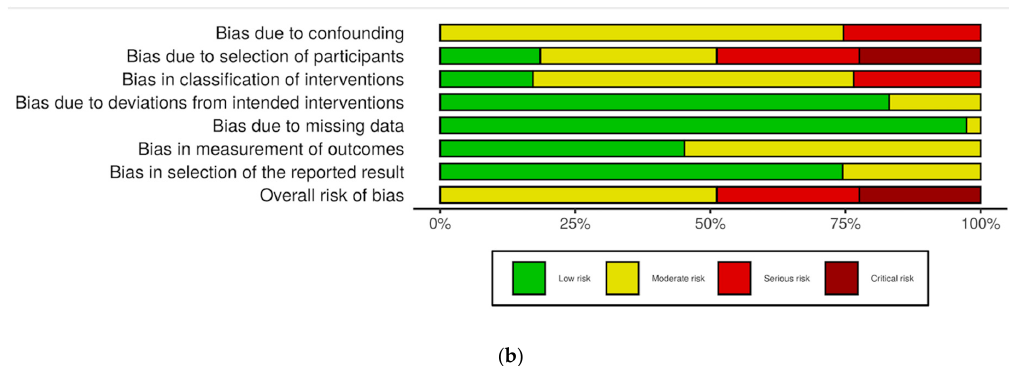
Figure A1. Risk of bias in non-randomized studies-of interventions (ROBINS-I) assessments of non-RCTs. ( a ) “Traffic-light” illustration of risk of bias in individual studies. (b) Weighted bar plots depicting risk of bias judgement distributions within each domain.